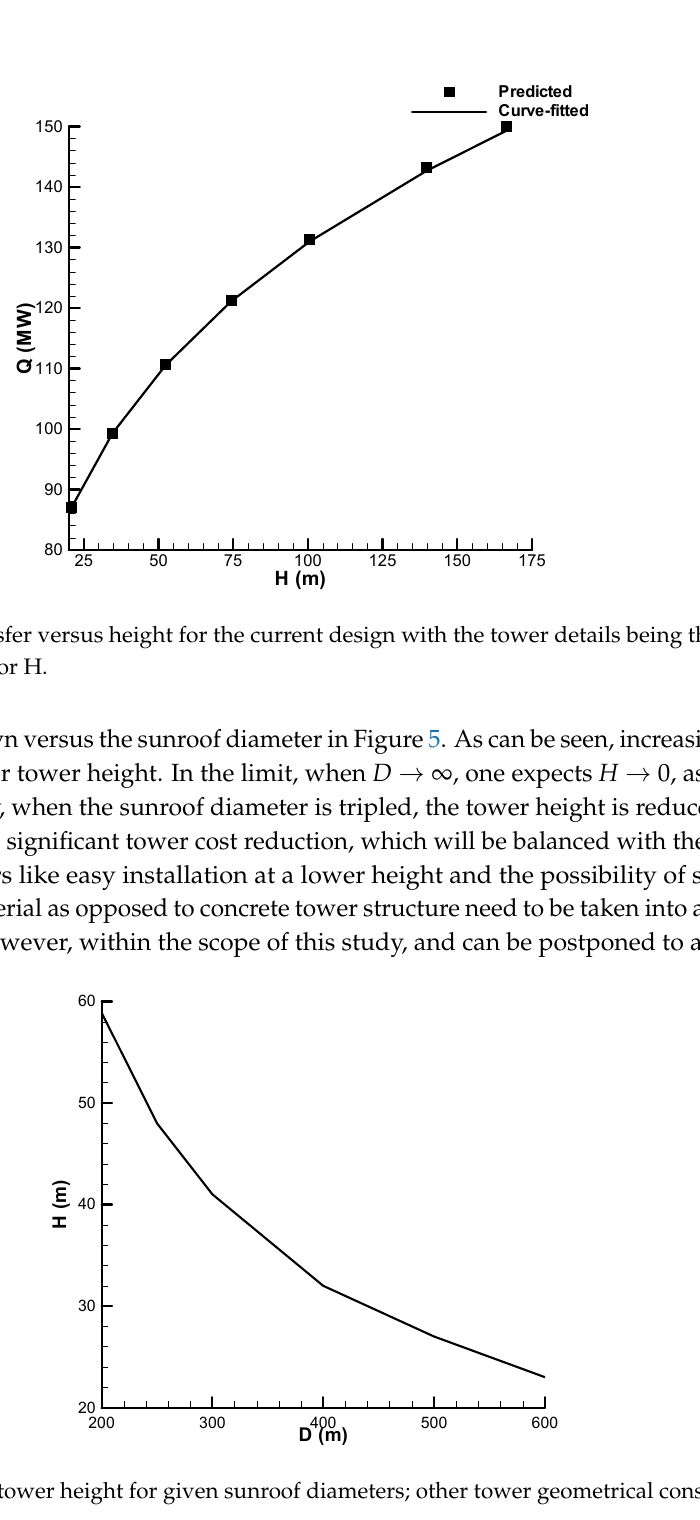
Figure 5. Required tower height for given sunroof diameters; other tower geometrical constraints are as those of [5].